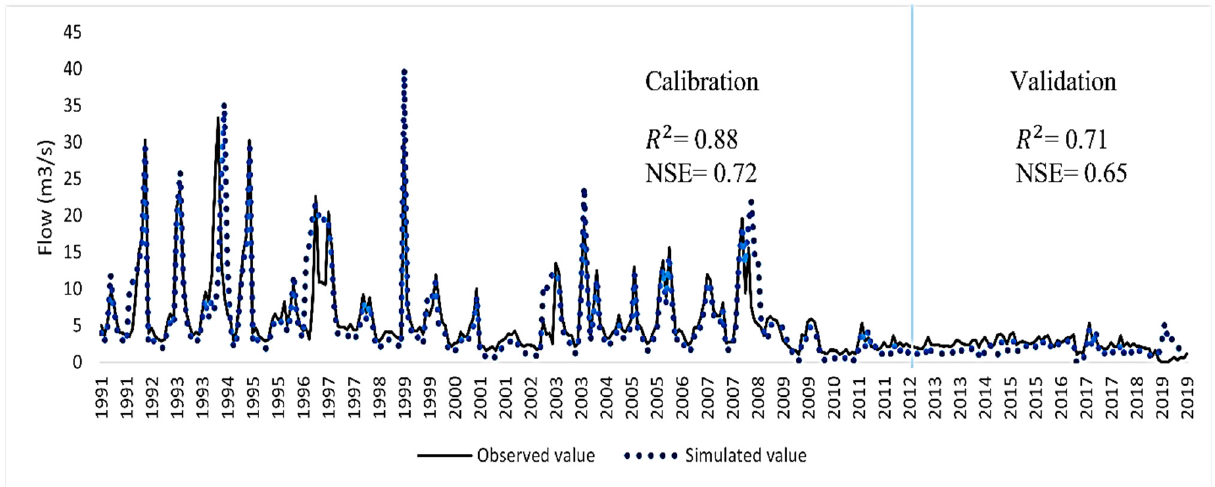
Figure 5. Monthly observed vs. simulated discharge during model calibration and validation for 1991–2019 at the Roodak gauge.